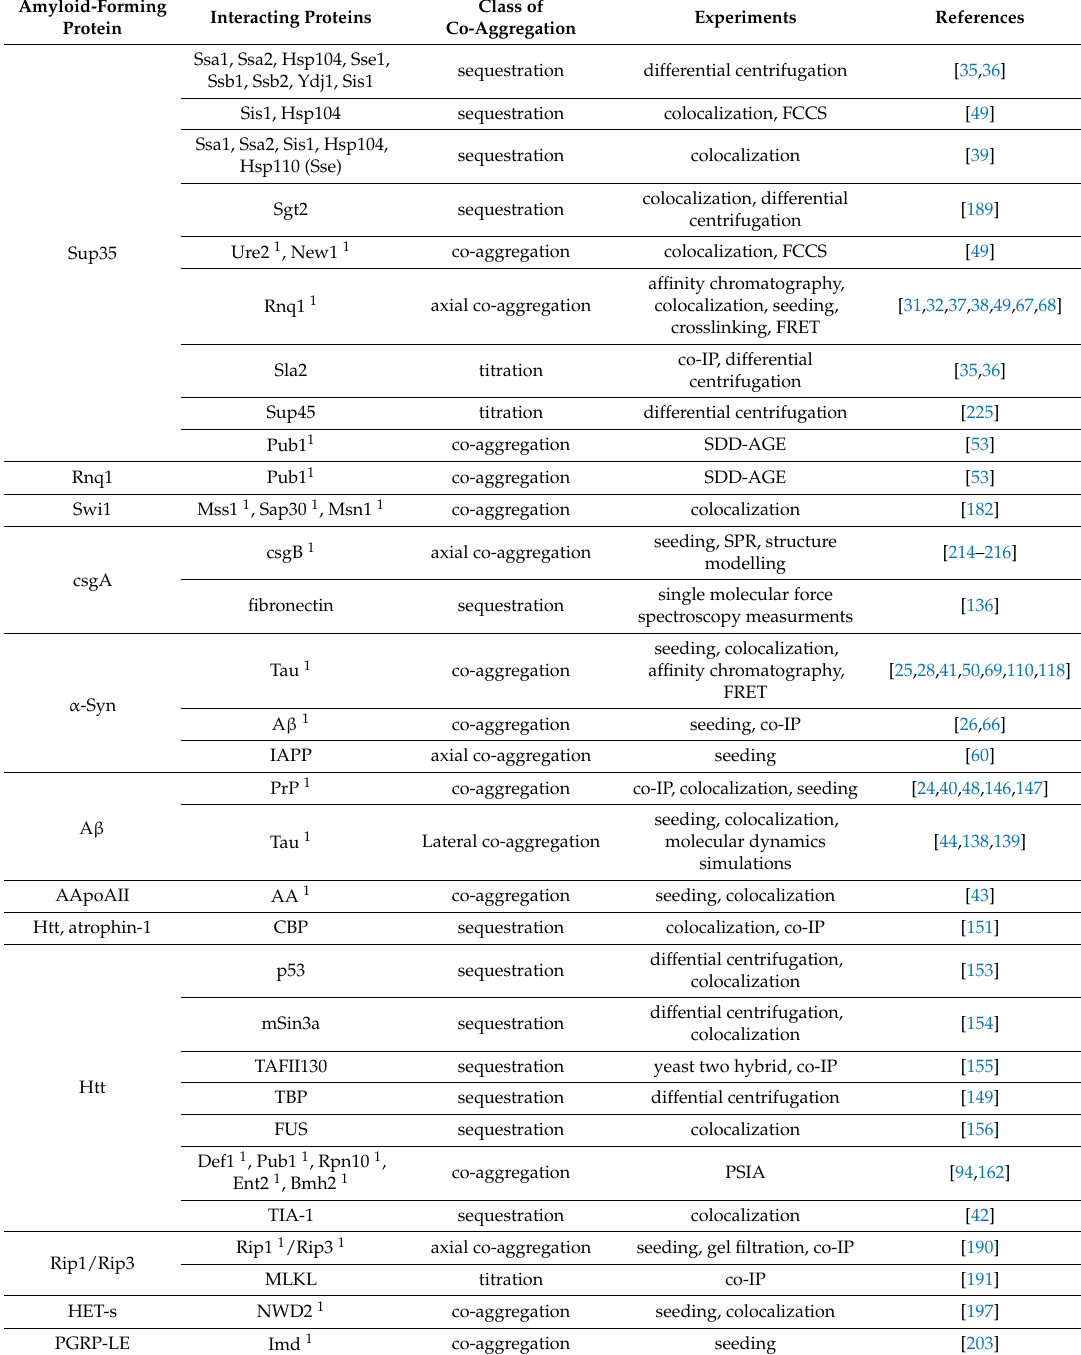
Table 1. Different examples of protein aggregation related to